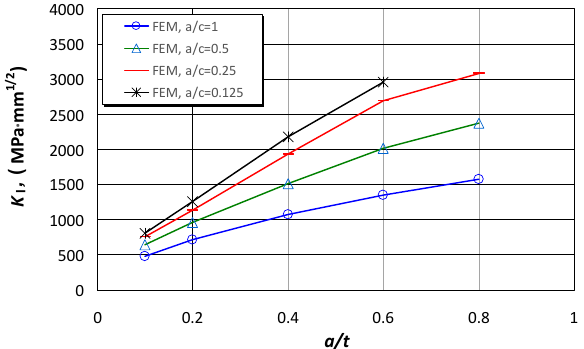
Figure 10. SIF solutions for crack oriented at α = 60°.